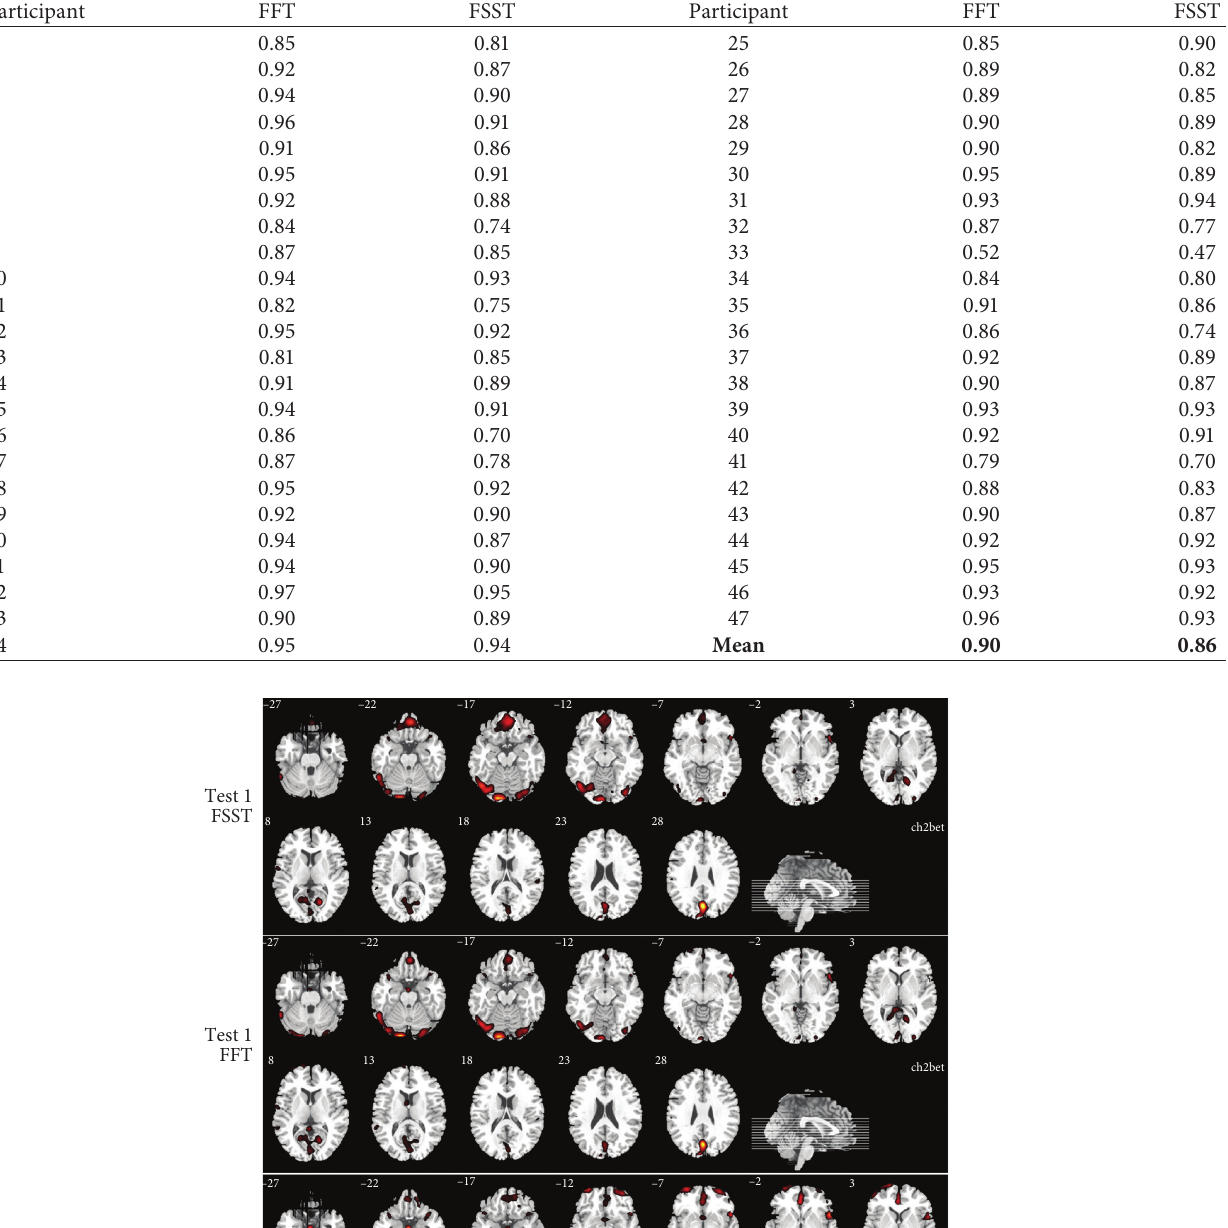
Table 2: Coefficient values of ALFF for FFT and FSST in resting-state experiment.